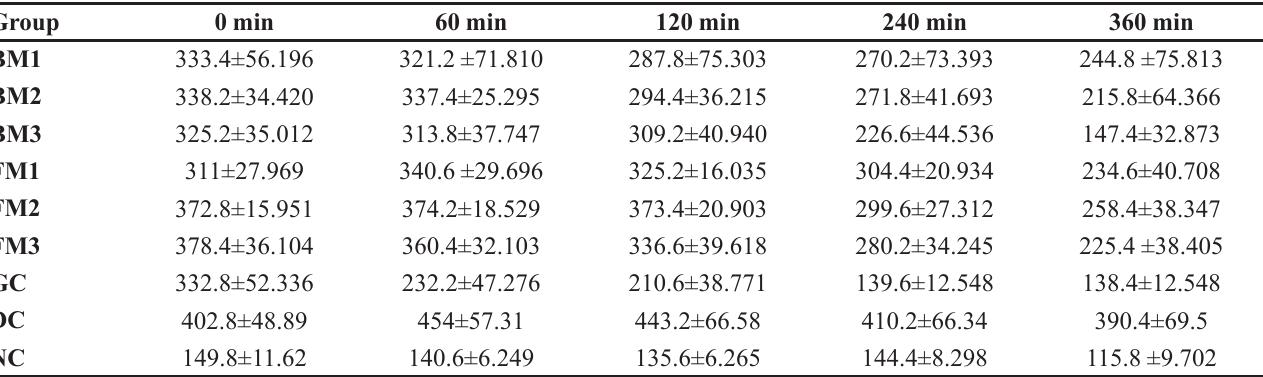
TABLE I - Acute effects of methanol extracts of C. ovata var . palaestina bud and fruit on fasting blood glucose levels (mg/dL) in diabetic mice. Values are presented as the mean±SEM Group